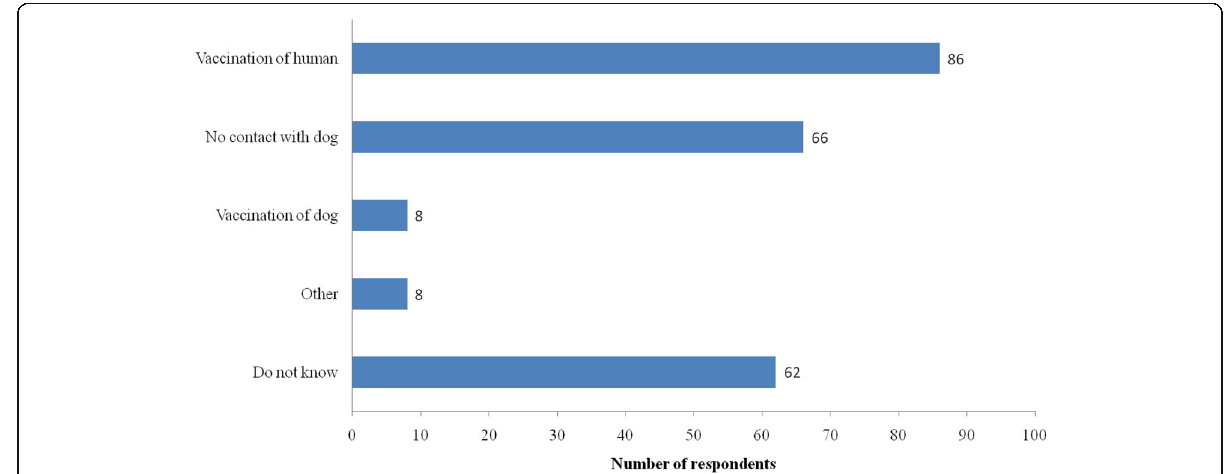
Fig. 1 Respondents ’ replies about how rabies can be prevented ( n =